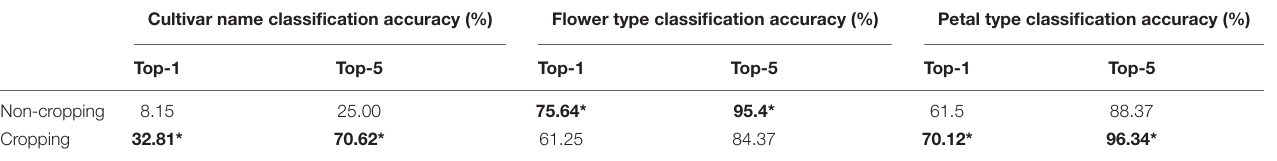
TABLE 2 | Influence of cropping or non-cropping models on a generalization of 2019 cultivars classification.